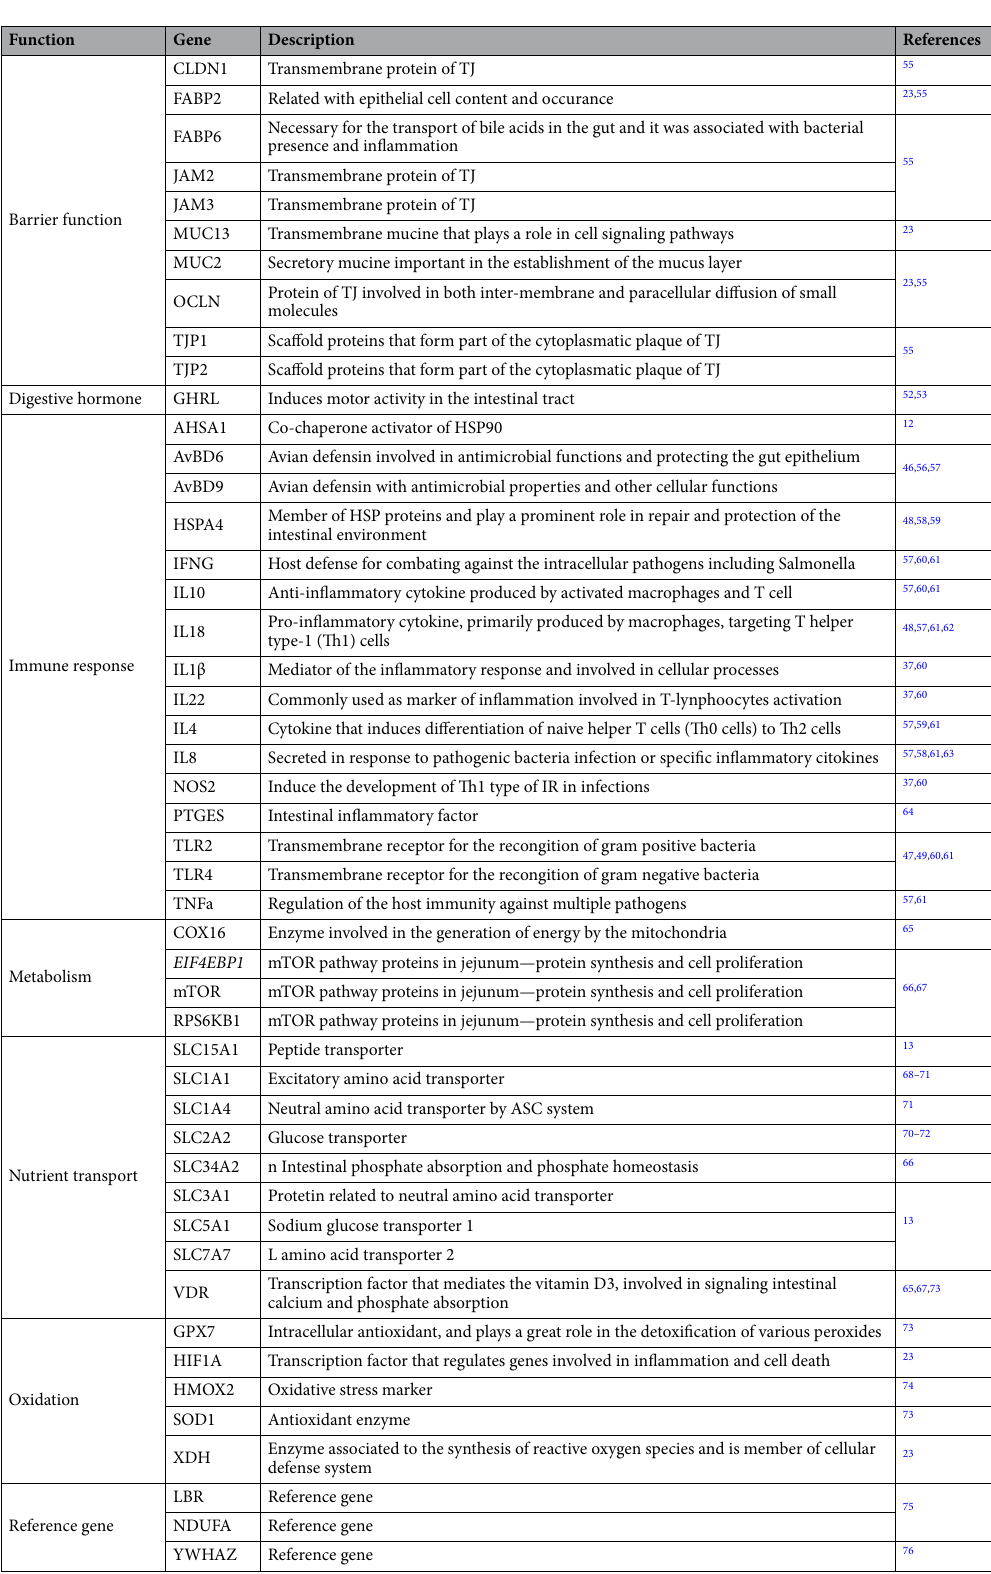
Table 3. Summary of the bibliography used for the selection of the genes included in the panel and a brief description of their main